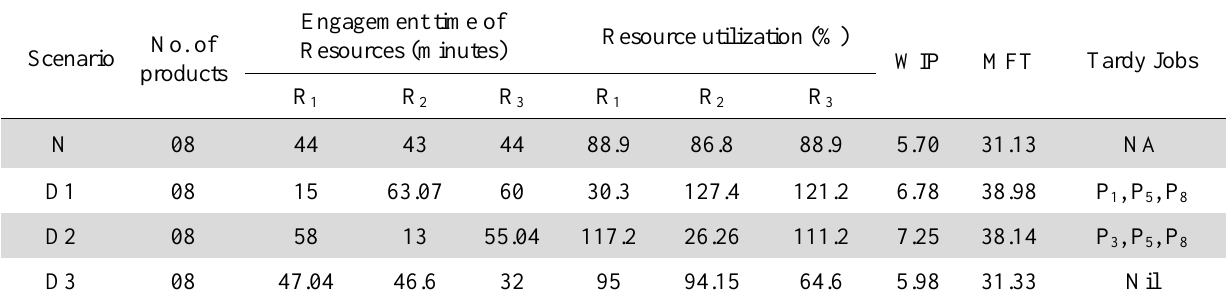
Scheduling output under normal situation (N) and under disturbances (D1 –